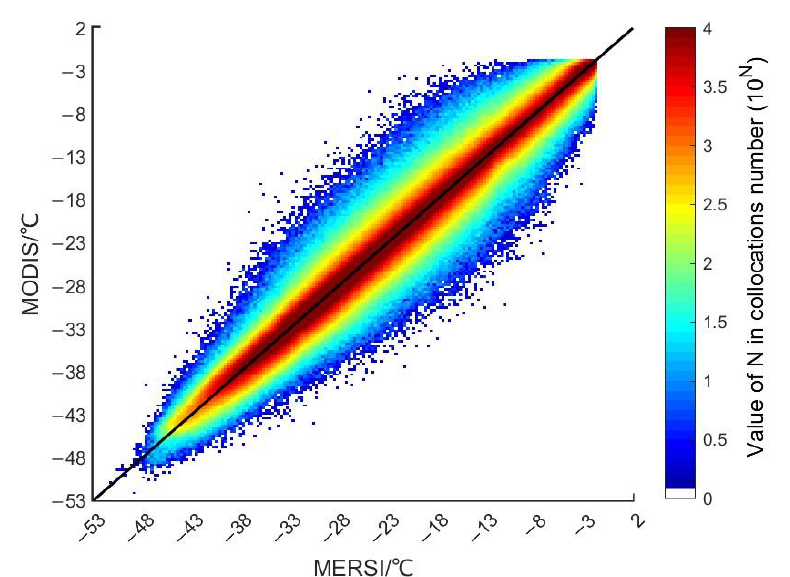
Figure 11. Scatter plot diagram of MERSI and MODIS IST after calibration from January to December.